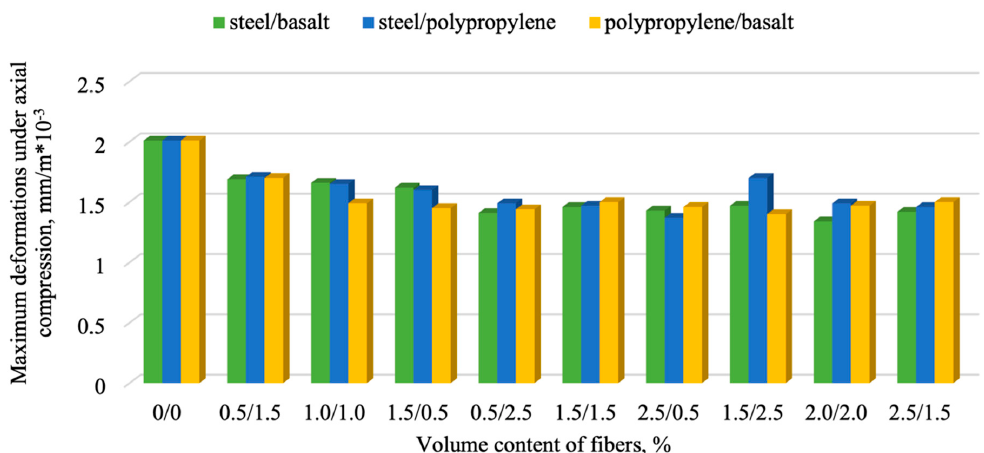
Figure 8. Dependence of the tensile strength in the bending of fiber-reinforced concrete on the type of fiber combination and volume content.